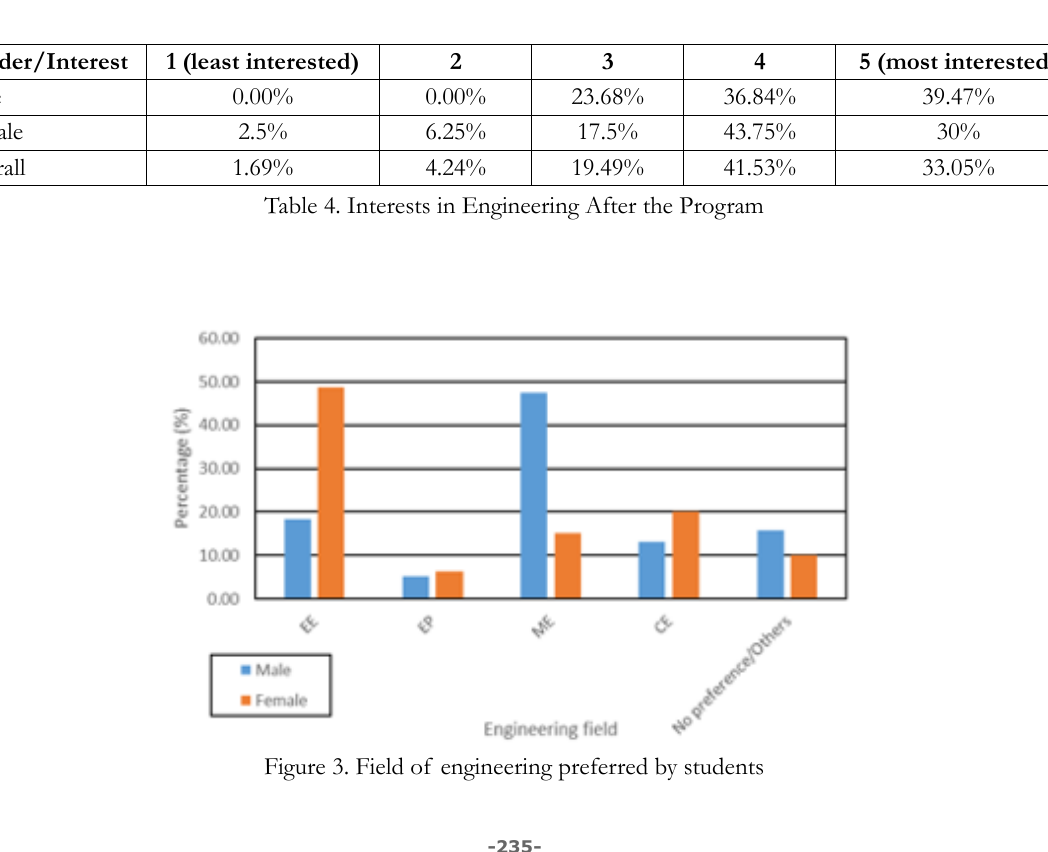
Gender/Interest